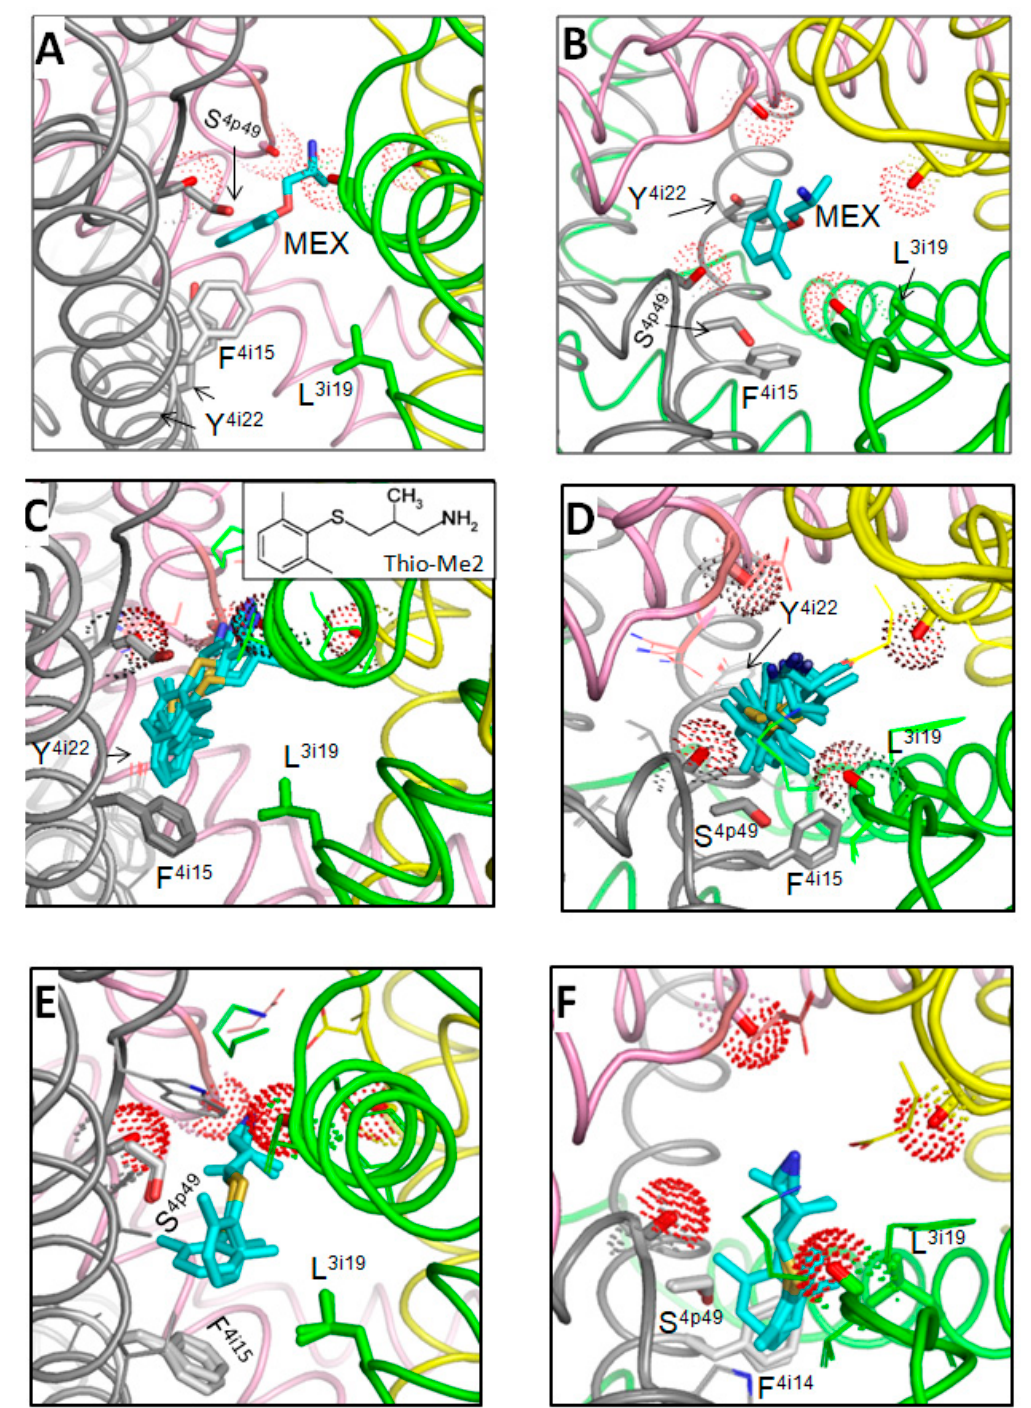
Figure 2. UDB binding pose of MEX and its potent analog, Thio-Me2, in the cryo-EM structure of Nav1.5. Pore-facing backbone carbonyls in position p48 are shown by sticks and dots. ( A , B ) Intra- membrane ( A ) and extracellular ( B ), views of the MEX binding pose that corresponds to UDB. The aromatic ring of MEX binds between two aromatic residues in IVS6 in the edge-to-plane mode. The ammonium group deeply penetrates into the outer pore and interacts with the pore-facing backbone carbonyls (red dots) in positions p48 to which the ammonium group of the selectivity-filter lysine is attracted in the ligand-free channel [42]. ( C , D ) UDB of Nav1.5 by Thio-Me2. Intra-membrane ( C ) and extracellular ( D ) views of low-energy structures. ( E , F ) TB of Nav1.5 by Thio-Me2. Membrane ( E ) and extracellular ( F ) views of low-energy